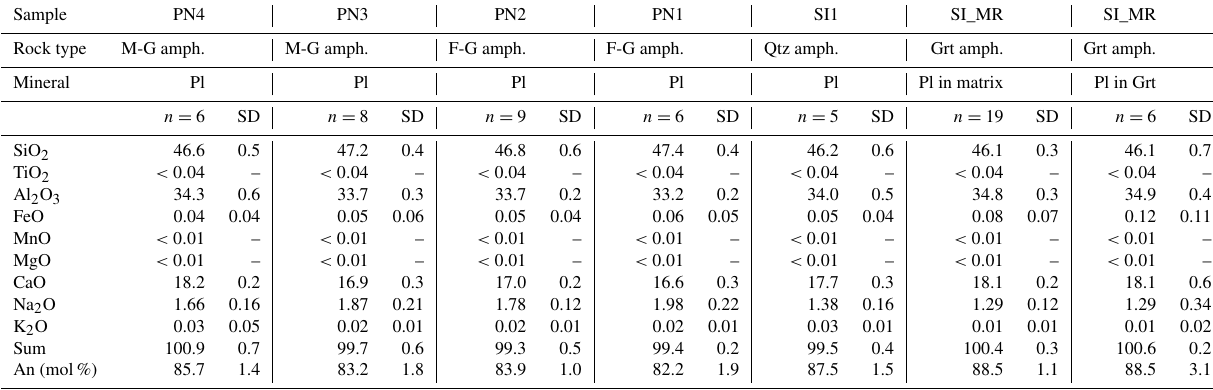
Table 2. Electron microprobe analysis of plagioclase (average values, wt%). Sample Rock type